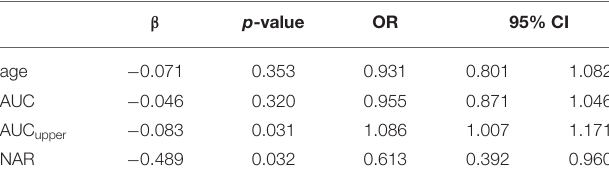
TABLE 3 | Predictors of vascular events during 36-month